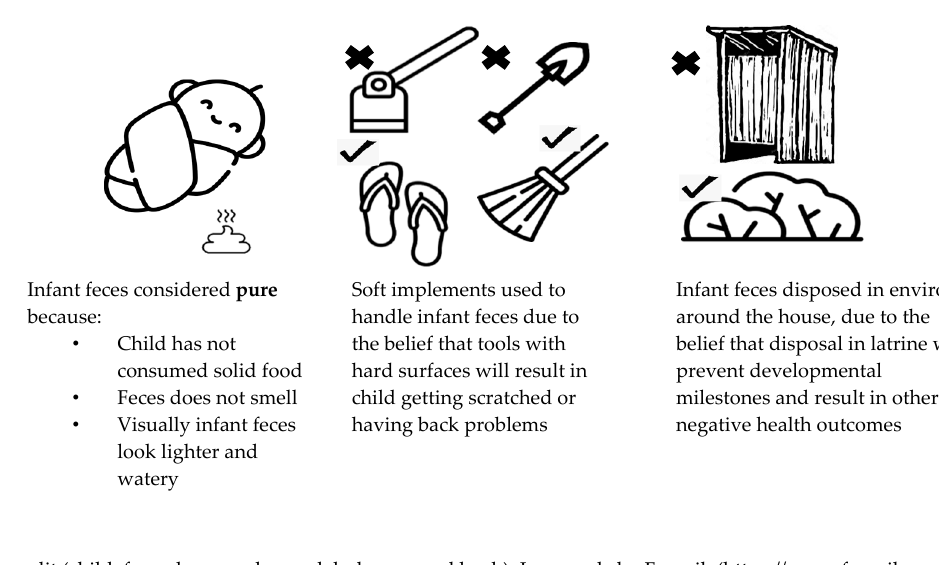
Figure 1. Summary of perceptions, practices and changing perspectives of infant feces in Geita region, Tanzania.